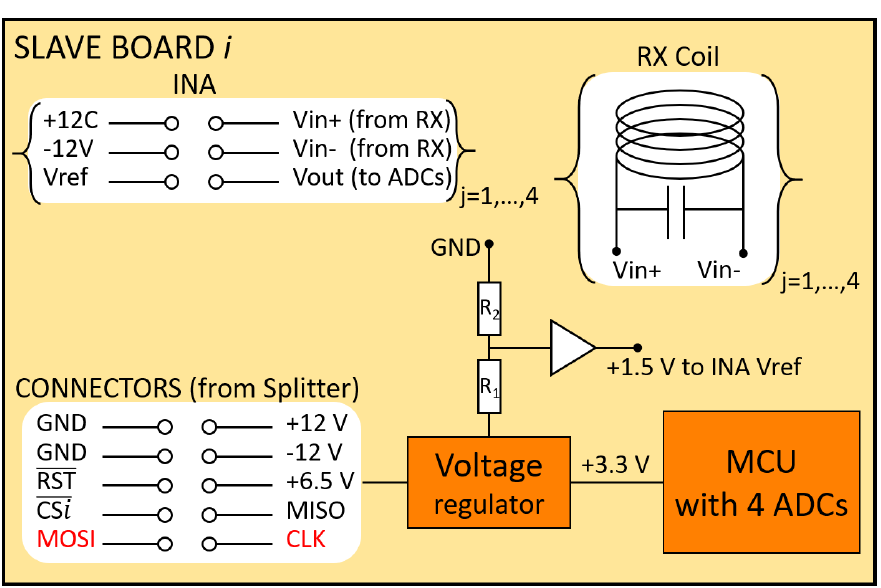
Figure 10. Simplified schematic of a slave board: the color red indicates buffered